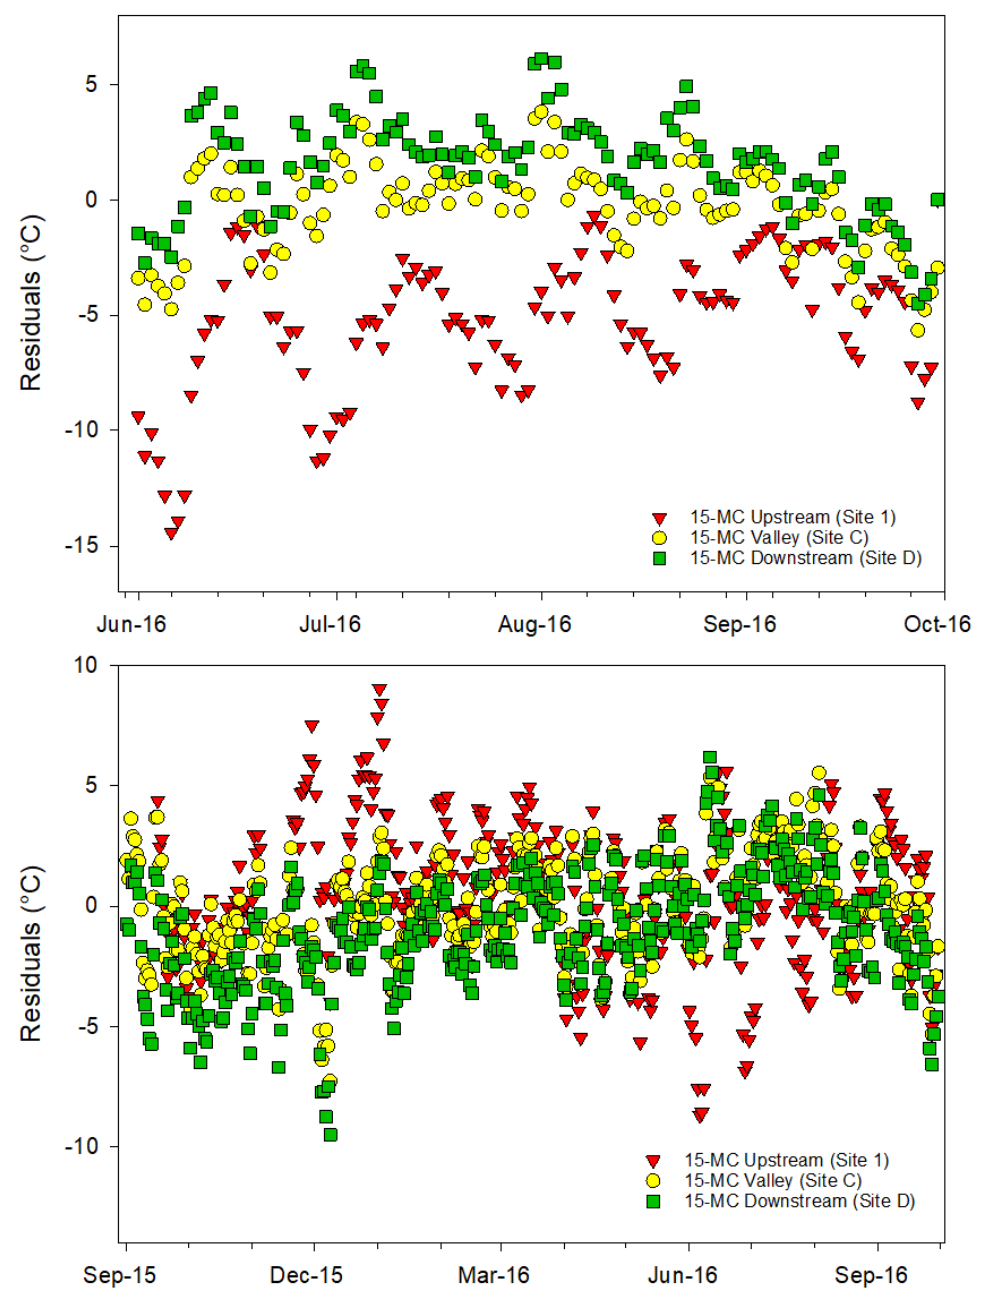
Figure 12. Residuals for selected sites for 7DADM_Jun–Sep ( top ) and 7DADM ( bottom ). Sites are listed in order from most upstream to most downstream. Sensor location can be found in Figure 3.